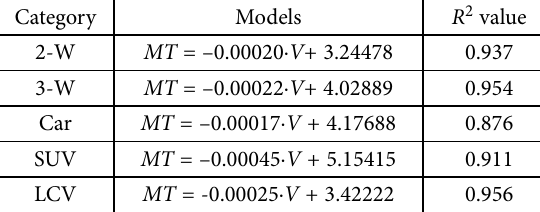
Table 5. Models for MT for different vehicles